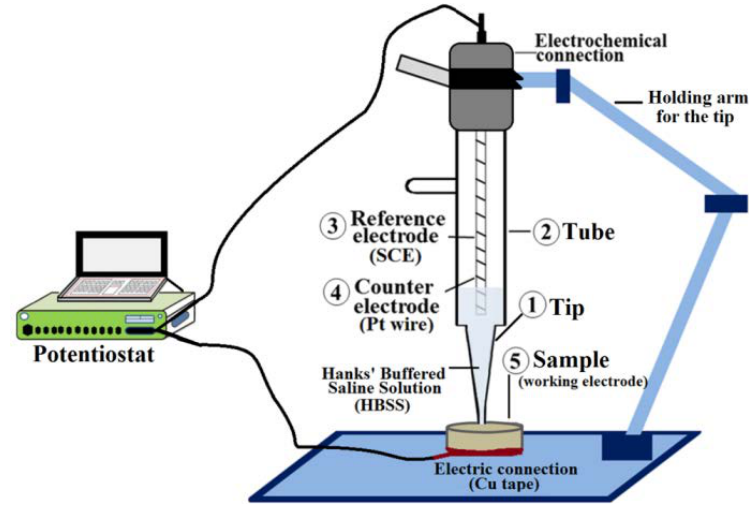
Figure 1. Schematic representation of the mini-cell system adopted in this work. The setup was composed of: (1) a plastic tip filled with the testing solution and in contact with the sample surface; (2) a tube, containing (3) a saturated calomel (SCE) as a reference electrode, and (4) a platinum counter-electrode; (5) a working electrode, which is the sample surface to be analyzed. Electric contact was achieved using a conductive copper adhesive stripe on the sample backside and a clamp, to ensure a good contact among the components. A digital microscope (Keyence VHX 900, Keyence Deutschland GmbH, Neu-Isenburg, Germany) was used, with a magnification 200 × , to determine the area of the corrosion test spot. The tip and the tube of MCS were filled with 3 mL of Hanks’ buffered saline solution (HBSS, Thermofisher product number 14175095). The experiments were performed at room temperature (25 ± 1 ◦ C). The tip of the MCS was placed directly on the surface of the specimen, analyzing 0.4 mm 2 of its surface in each test; the electrochemical measurements started as soon as the tip had contact with the surface. The experiments were driven by a potentiostat (Autolab PGStat 302, Metrohm AG, Herisau, Switzerland), with frequency response analysis (FRA) software (Nova 2.0) connected to the electrochemical setup. Electrochemical impedance spectroscopy (EIS) tests were performed between 100 kHz and 10 mHz, at a potential amplitude of 10 mV around the OCP. The OCP was registered during the initial 20 s for stabilization, before starting EIS. Measurements were performed at 20 and 1200 s exposure of the surface to the medium. The EIS measurements are only possible on such a short time scale due to the small dimensions of the tip, in the range of 700 µ m diameter. In order to investigate if the coating was stable upon prolonged exposure, single EIS experiments were performed up to a period of 24 h. After finishing the test, the sample was dried using pressured air and stored in controlled environmental conditions. Based on ASTM G102, the corrosion rate was defined